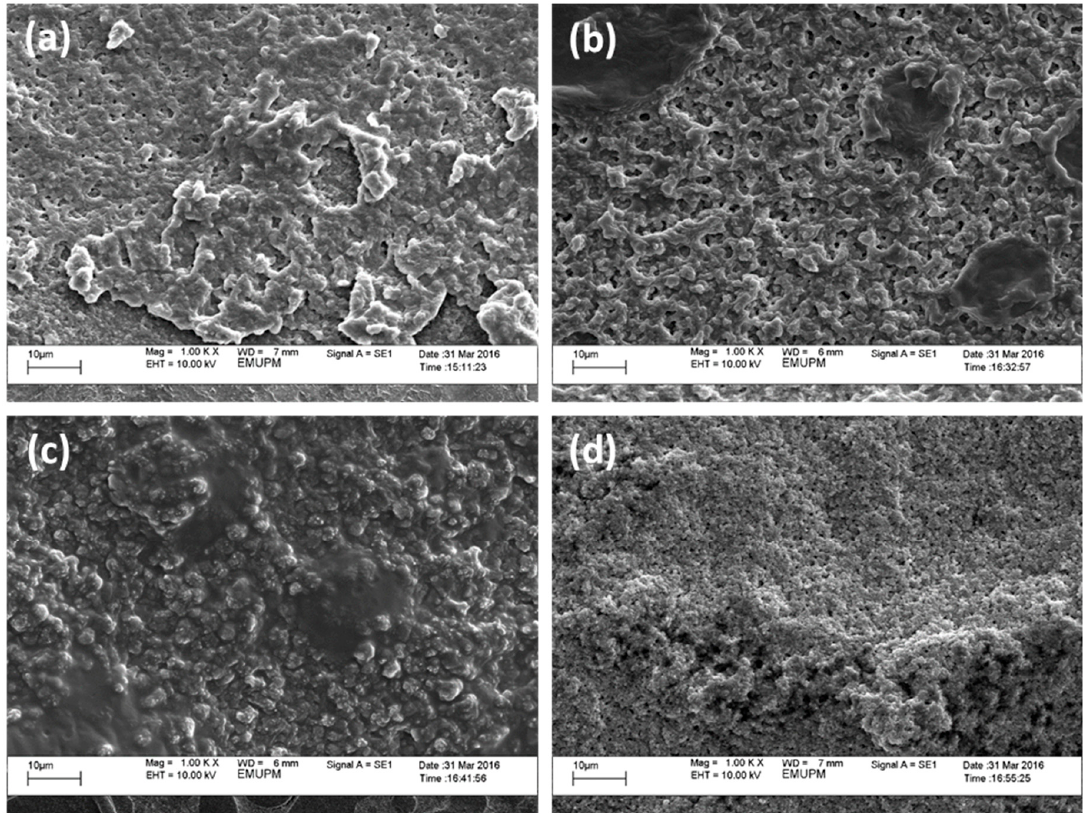
Figure 13. SEM micrograph PUA/LiClO 4 25% electrolyte with EC ( a ) 0% ( b ) 3% ( c ) 9% ( d ) 15%.